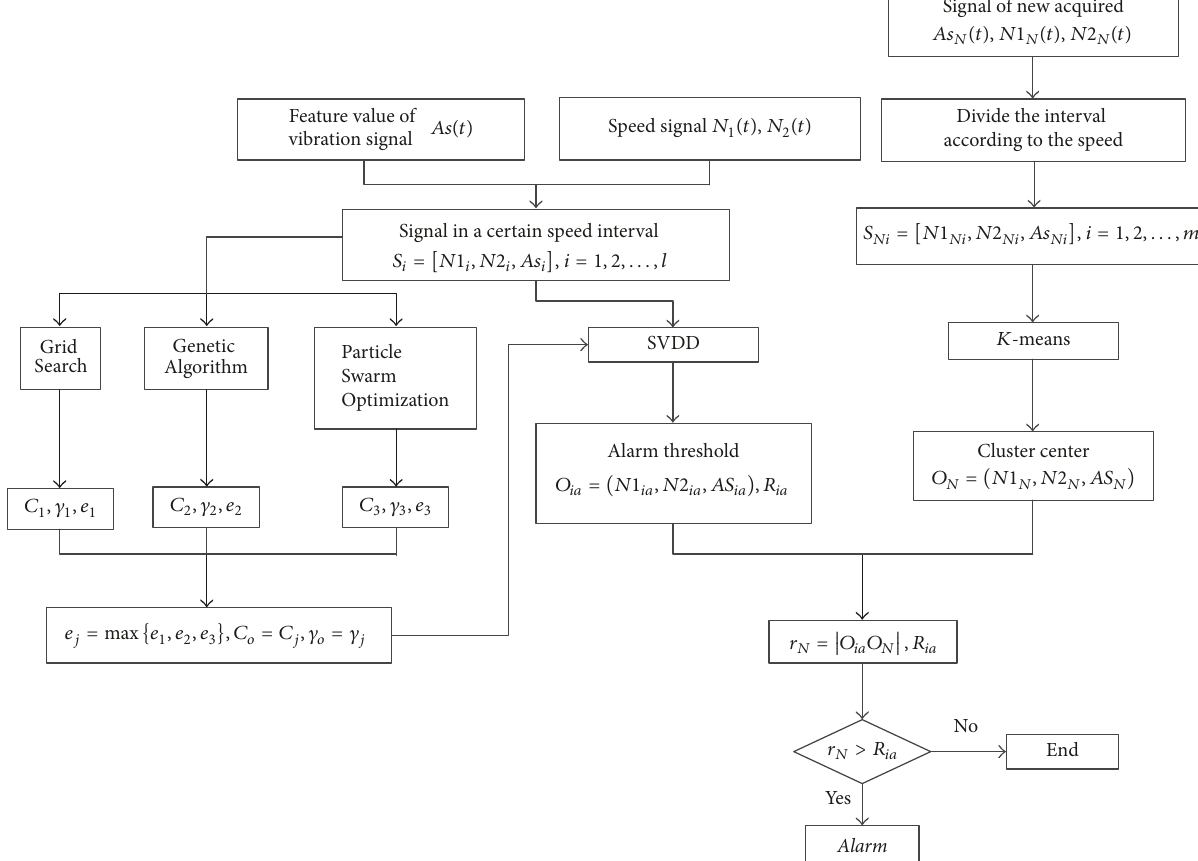
Figure 5: Schematic of the proposed method.